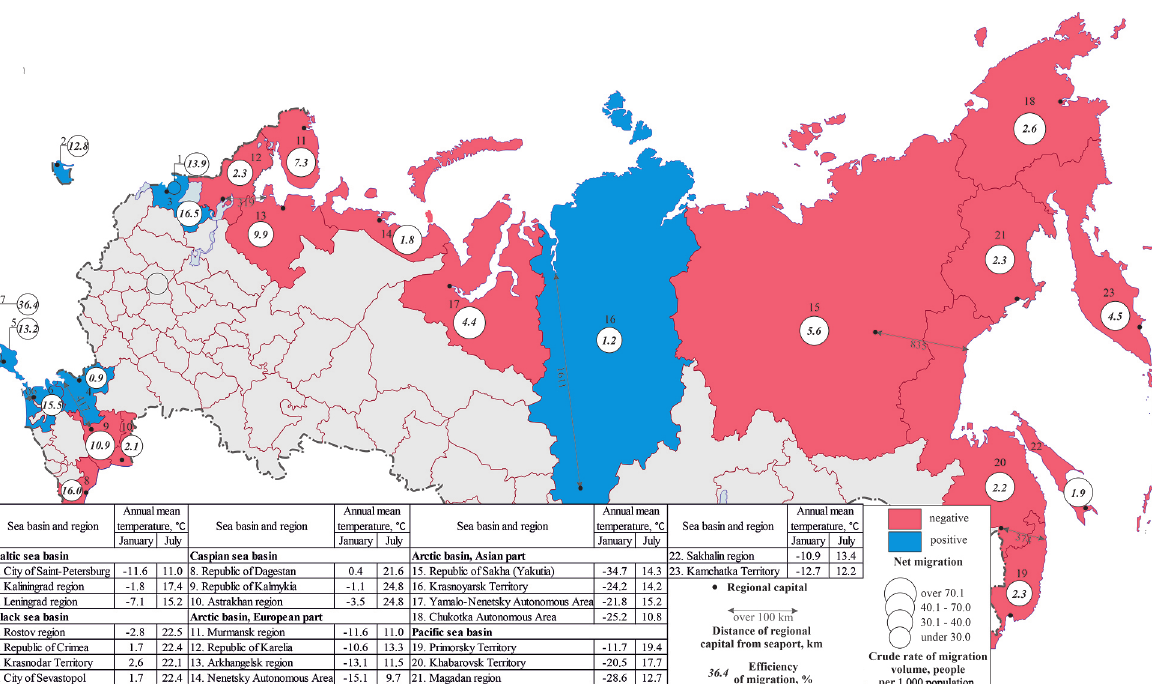
Crude rate of net migration, per 1,000 people